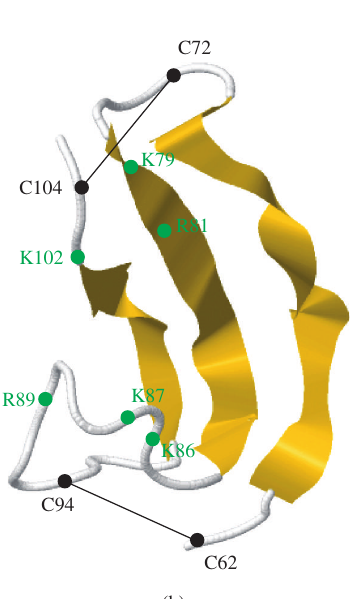
FIGURE 1: Protein structure of MK. (a) MK protein structure is shown. MK consists of two domains with similar size connected by an interdomain (white box). Numbers indicate amino acid position within the protein. The heparin-binding sites consisting of basic amino acids are located in the C-terminal domain (green boxes) [20]. (b) Tertiary structure of the C-terminal domain of MK protein “taken from the protein data bank PDB via http://www.rcsb.org/pdb/explore.do?structureId=1MKC.” The C-terminal domain contains three β -strands (yellow structure). Heparin binding clusters consisting of basic amino acids (cluster 1: K79, R81, K102; cluster 2: K86, K87, R89 in human MK) are displayed as green dots. C62, C72, C94, and C104 represent highly conserved cysteine residues forming disulfide bonds (black lines)